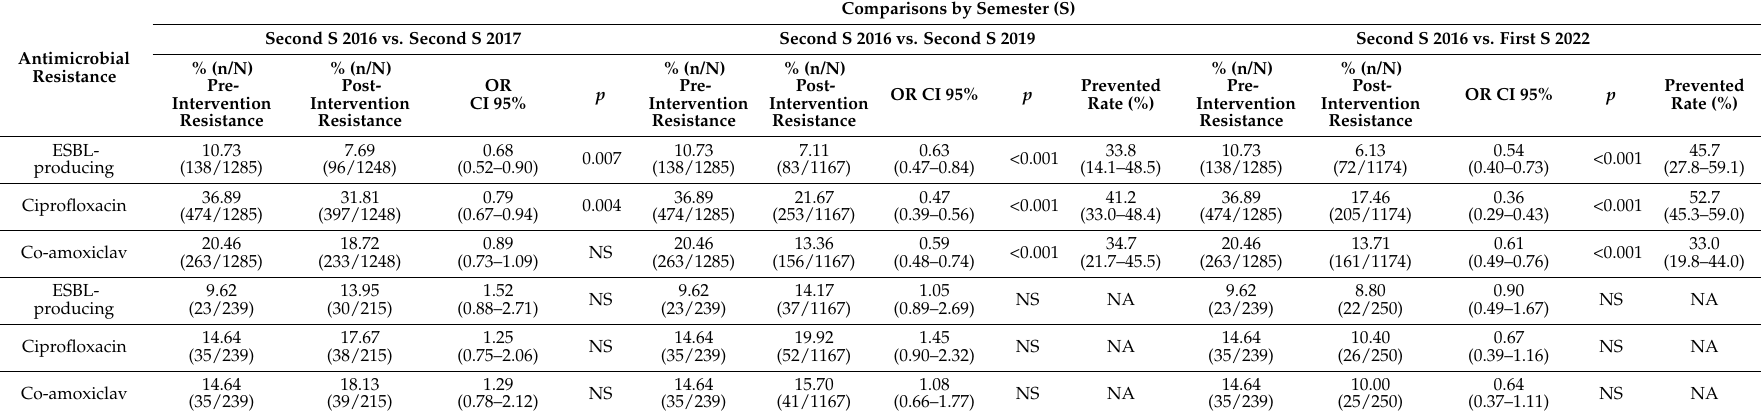
Table 2. Rates of microbiological